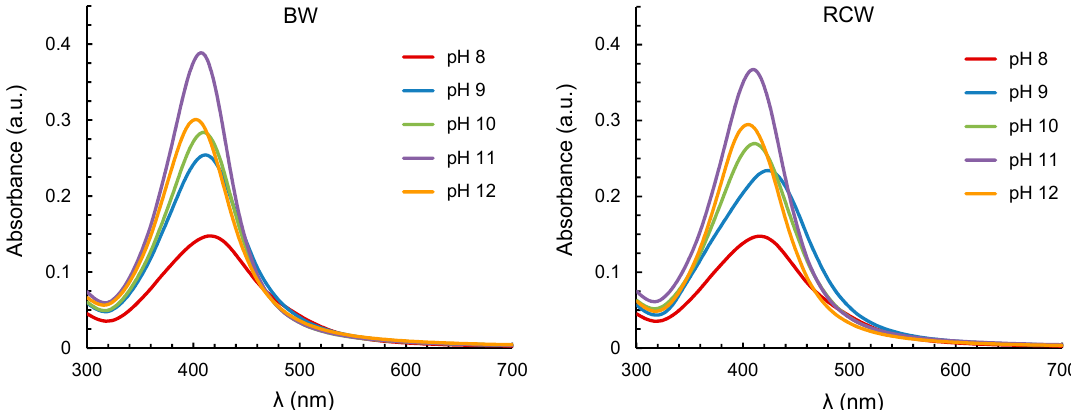
Figure 3. Effect of pH on the surface plasmon resonance (SPR) band of Ag-NPs obtained from bilberry waste (BW) and red currant waste (RCW) extracts (other conditions: T = 40 °C; Reaction time = 5 h; Silver-to-polyphenol ratio = 10 mol Ag + /mol GAE).